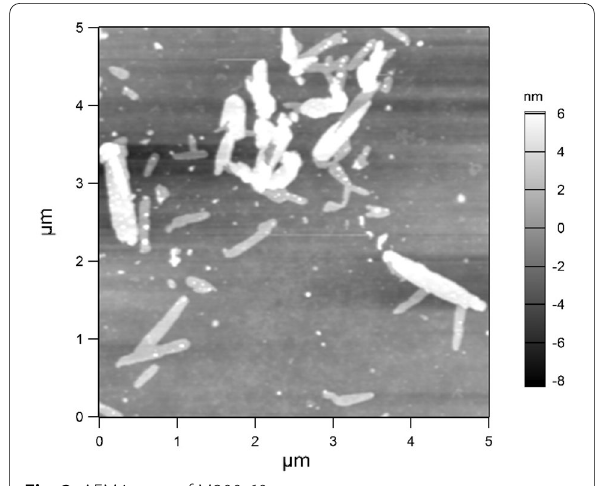
Fig. 2 AFM image of M200-60 √ 2 R c ) fiber radius, r ( r , which corresponds to the fiber = width, was calculated from the cross-sectional radius of gyration, R c , from plots constructed using Eq. (1).